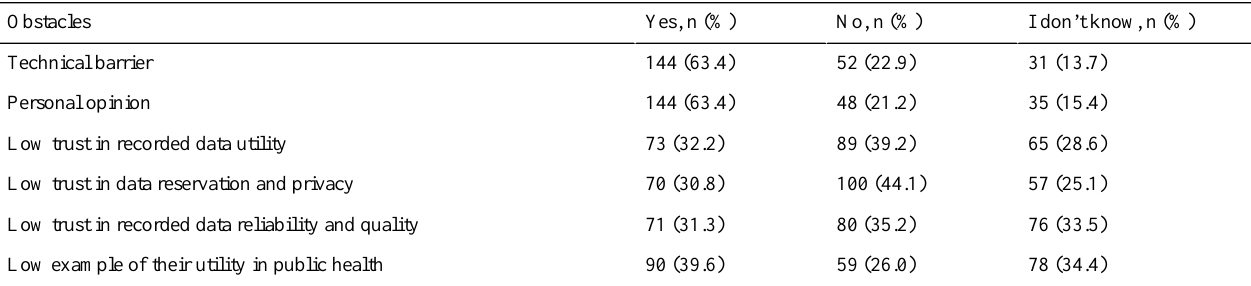
Table 5. Obstacles related to the use of health apps and wearables (N=227).